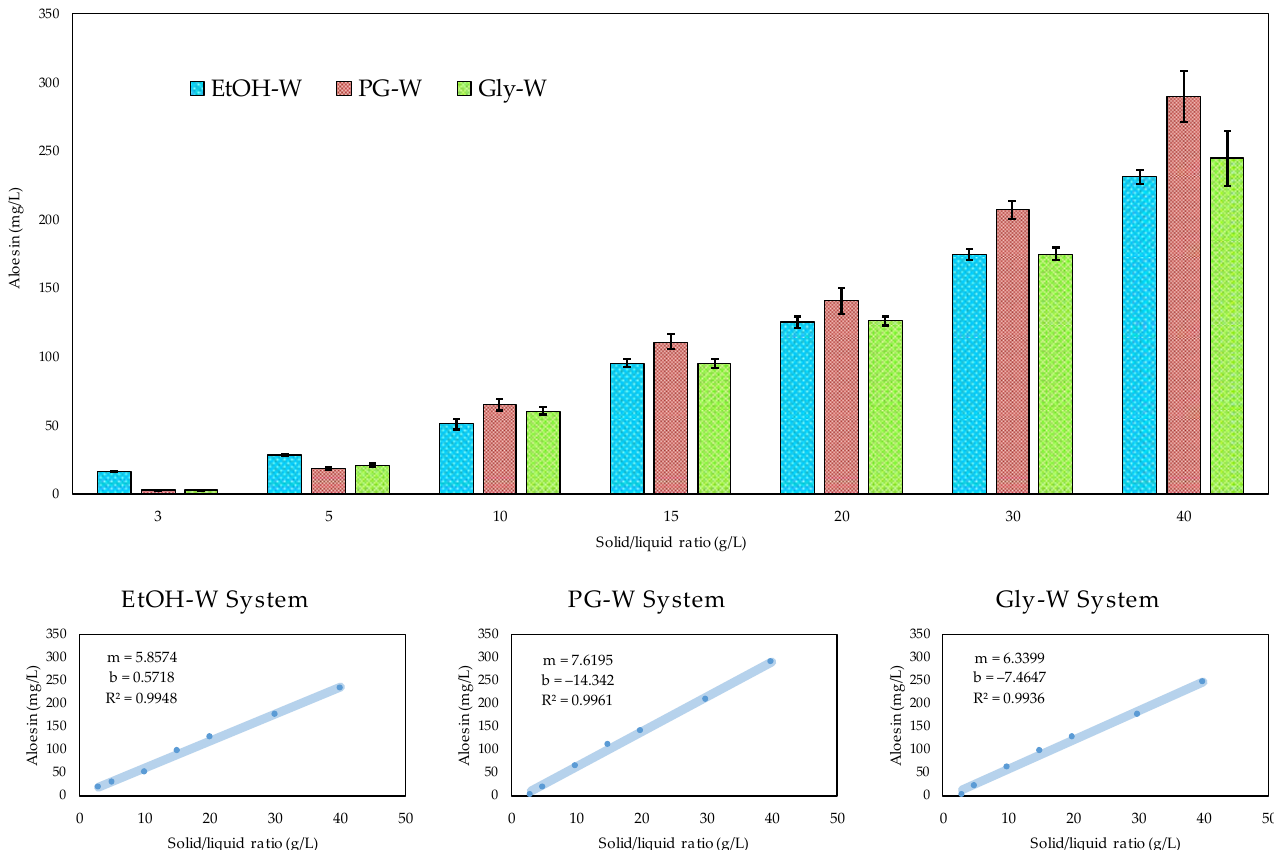
Figure 3. Dose–response effects of the solid/liquid ratio ( S / L ) on aloesin levels when processing the Aloe vera rind under the optimal conditions of time, temperature, and solvent concentration described in Table 2 for the three extraction sys- tems. In the graphs at the bottom, the dots represent the experimental values and the lines show the extraction pattern predicted by the linear equation.